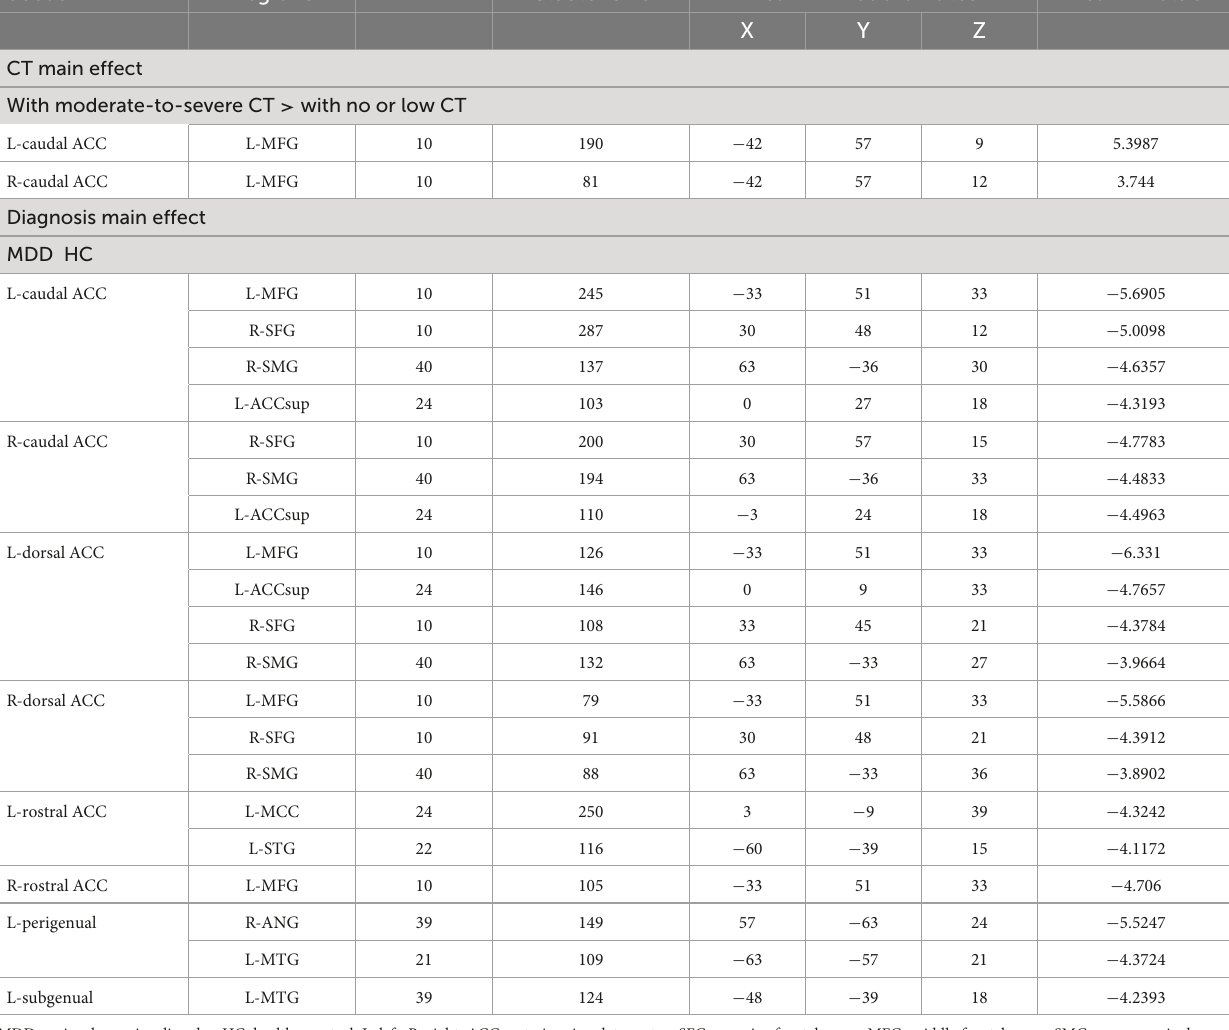
in FC between the dorsal ACC and left MFG, right SFG and right SMG indicates a functional disruption within the CCN in MDD patients, which may contribute to MDD patients’ difficulty in ignoring negative valence and stimuli from